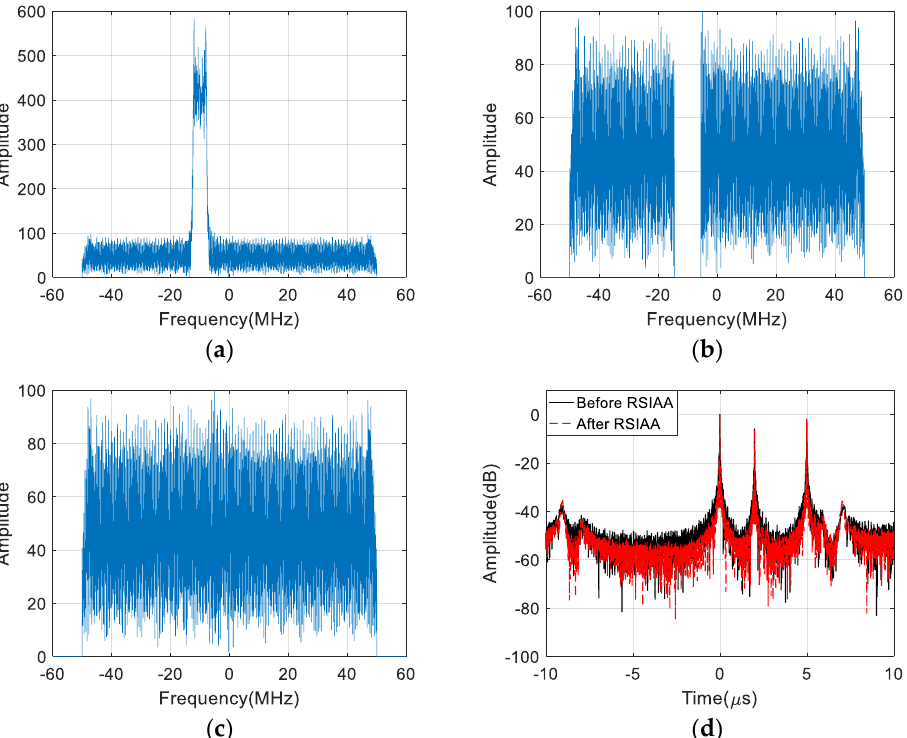
Figure 10. 1D Simulation results on point targets. ( a ) The spectrum with RFI; ( b ) after the band-stop filtering; ( c ) after the RSIAA; ( d ) comparisons of the pulse compression results.